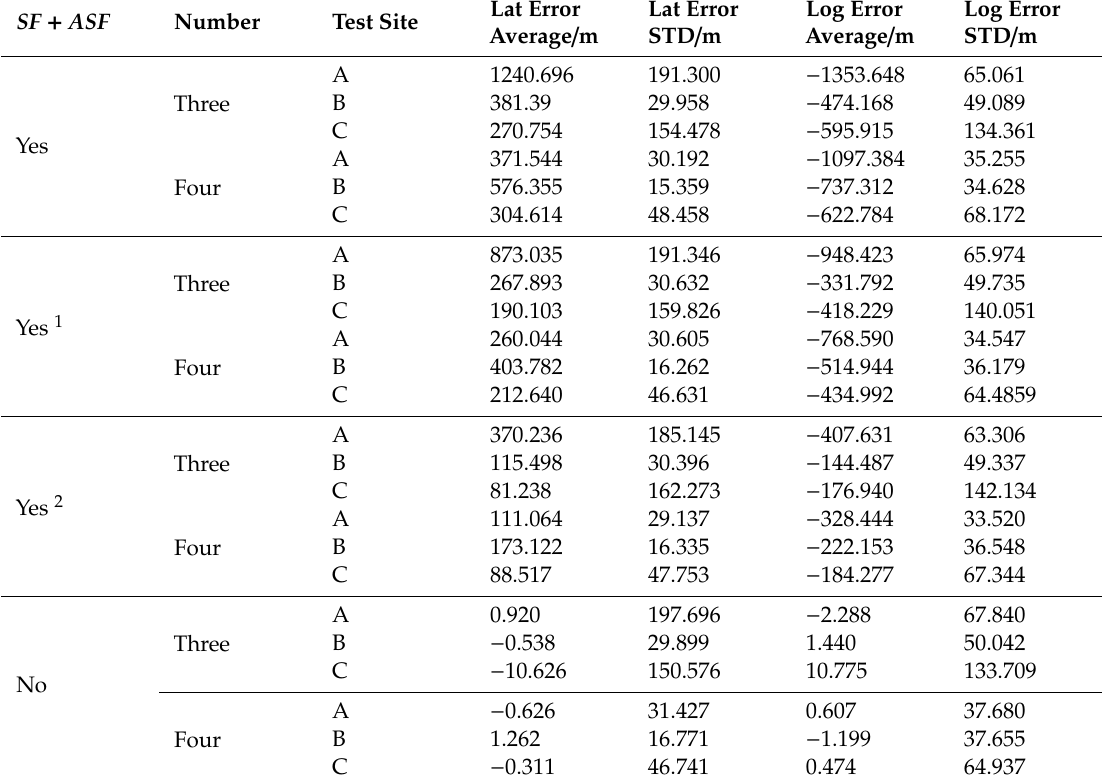
Figure 7. Scatter plot of position accuracy effected by SF+ASF and random noise. The upper three subgraphs are for three transmitters and the bottom three subgraphs are for four sites. Table 4. The position error’s directional components, random noise with STD 50ns.